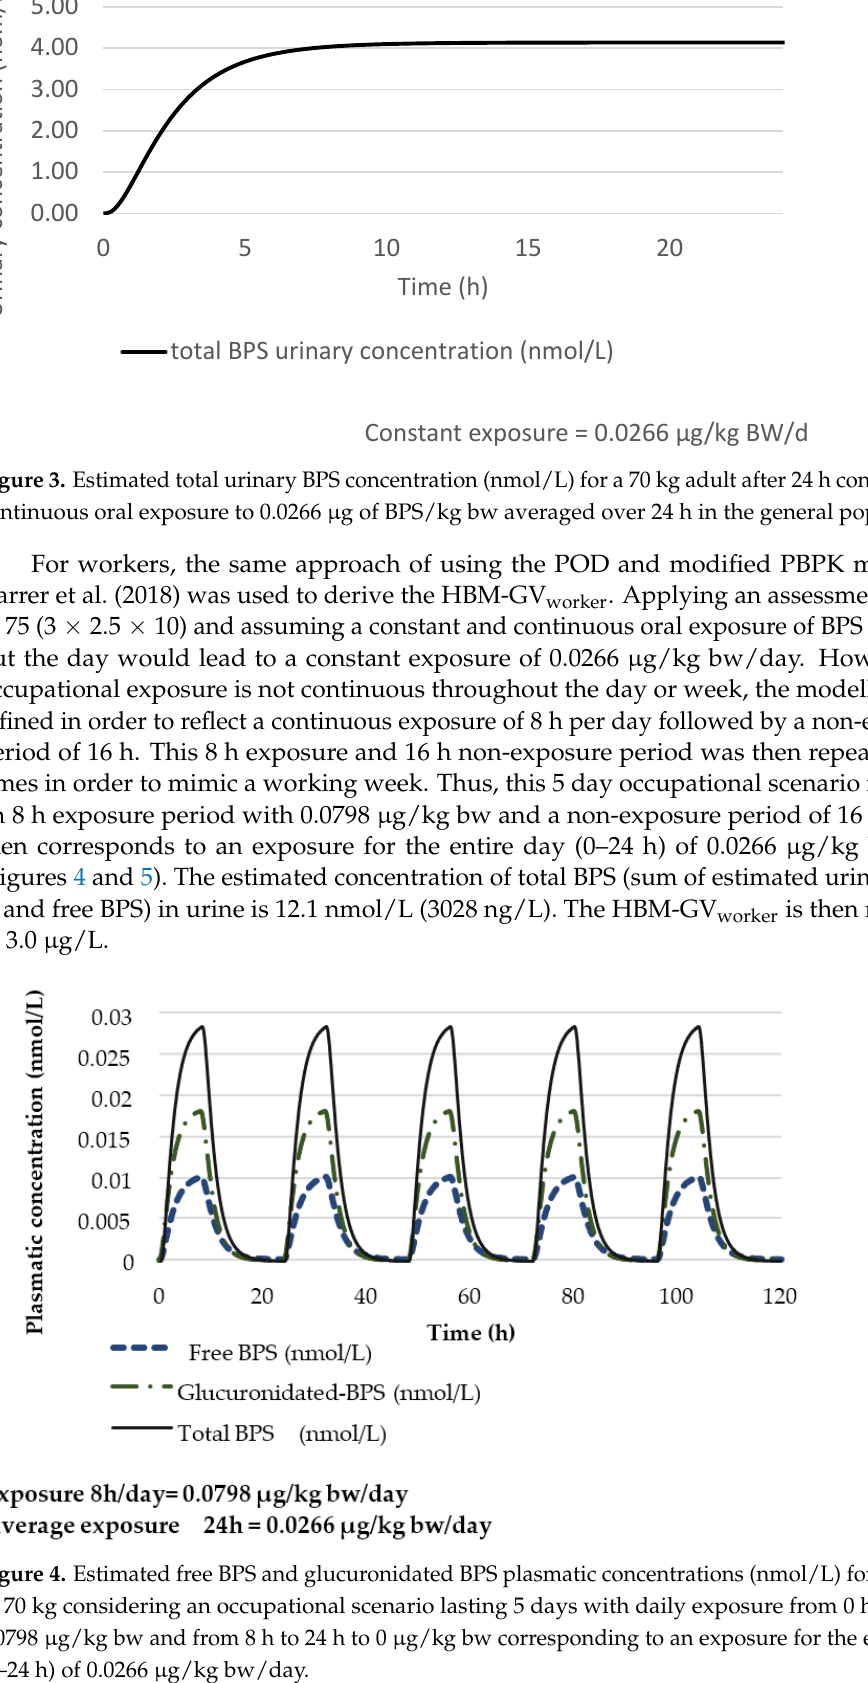
Figure 5. Estimated total urinary BPS concentrations (nmol/L) for an adult of 70 kg considering an occupational scenario lasting 5 days with daily exposure from 0 h to 8 h to 0.0798 µg/kg bw and from 8 h to 24 h to 0 µg/kg bw corresponding to an exposure for the entire day (0–24 h) of 0.0266 µg/kg bw/day. 3.2.2. Assessment of Exposure to BPS The data from studies reporting total BPS levels in urine were used to calculate the RCRs with the corresponding HBM-GVs detailed above. For the risk assessment for the general population exposed to BPS, data from seven studies from six different European countries were compiled. RCRs were calculated for each available dataset, with the excep- tion of studies for which P95 values were not reported. Some studies also reported results corrected by urine specific gravity. As with BPA, the results of those studies were used as